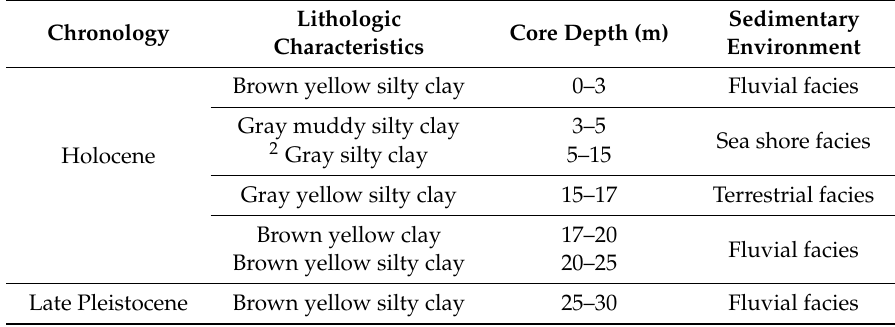
Table 2. Geological conditions for Tianjin.